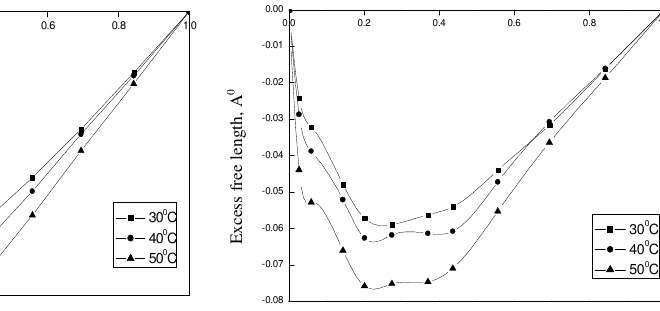
Mole fraction of benzyl benzoate Figure 1b. Variation of excess free length with mole fraction of benzyl benzoate in the mixture benzyl benzoate + acetonitrile